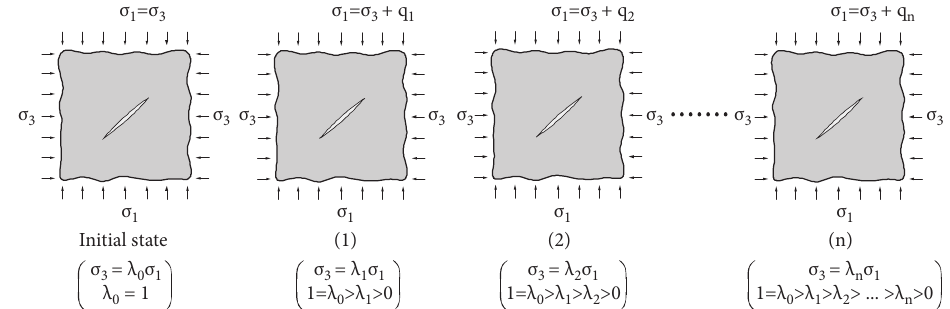
Figure 5: The ratio τ rθ / σ 1 at crack tip under different confining pressure coefficients. (a) μ λ � 0.3. (d) μ � 0.15, λ � 0.5.